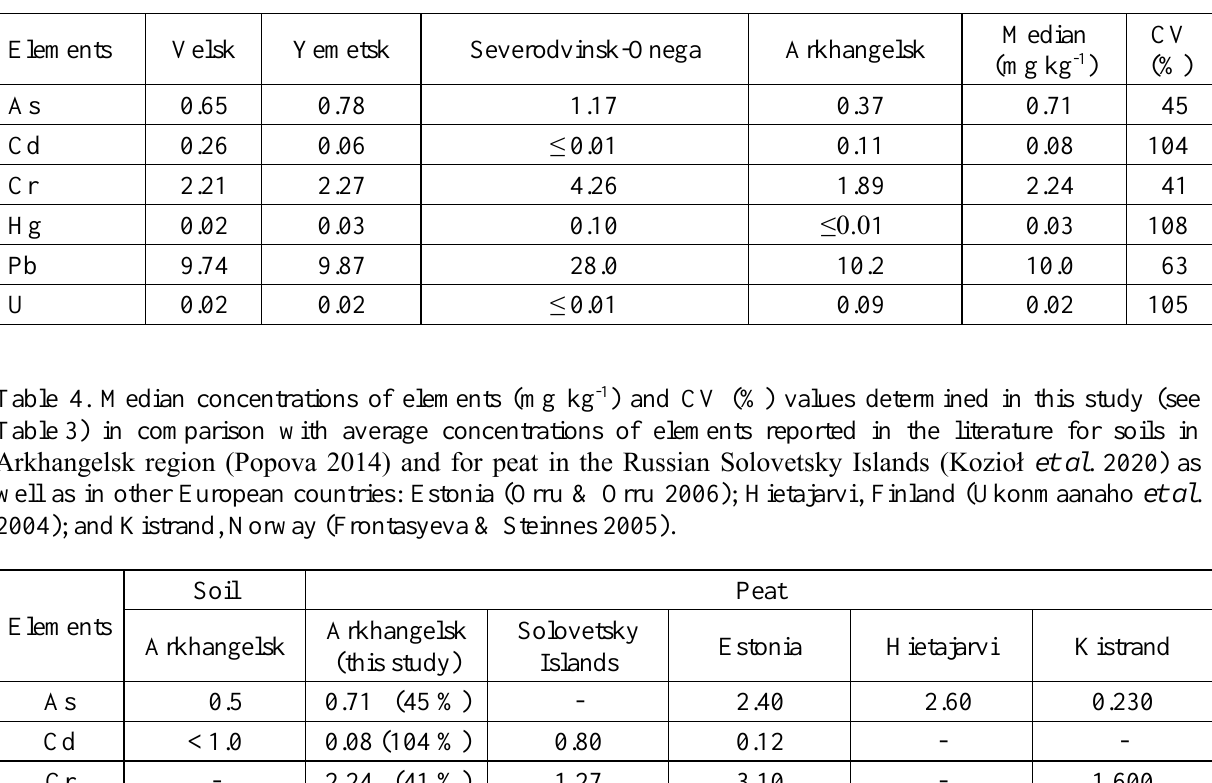
Table 3. The average concentrations (mg kg -1 ), median concentrations, and coefficients of variation (CV) of elements in the studied soils.